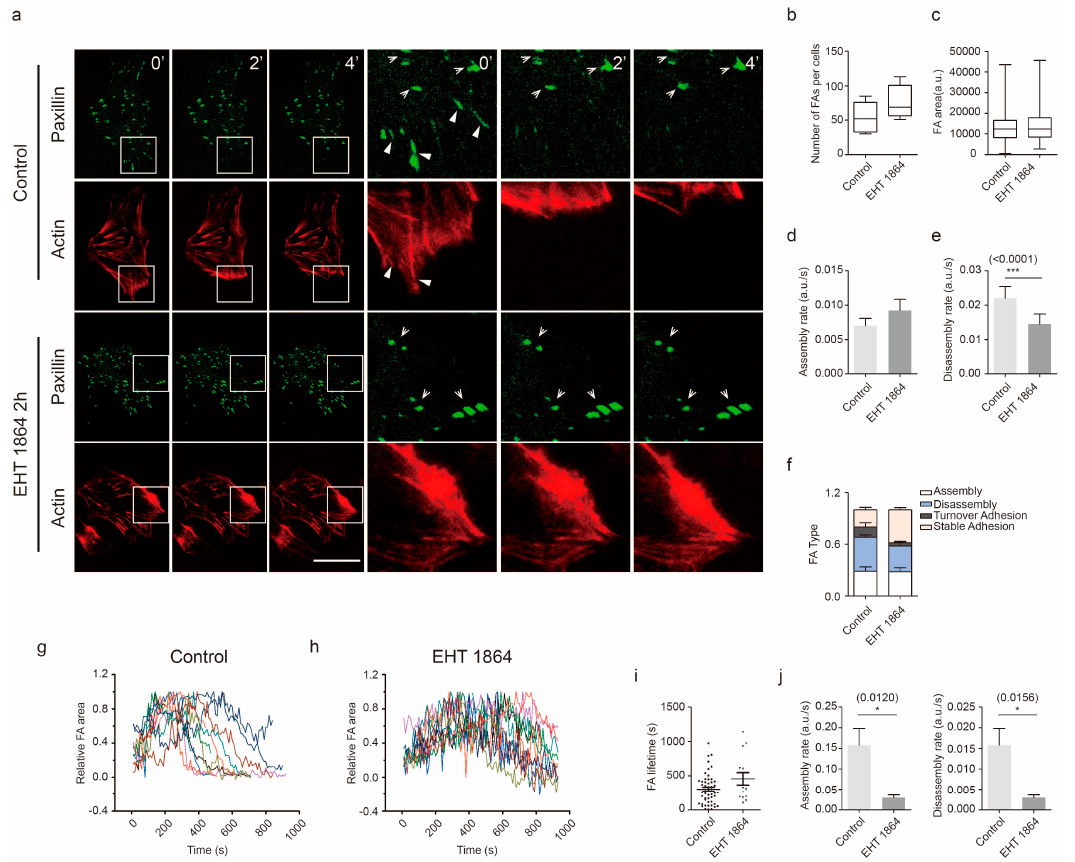
Figure 5. Rac1 signaling controls cell adhesion dynamics. ( a ) U87 transfected with Paxillin (green) and mCherry ‐ Lifeact ‐ 7 (red) were imaged by time ‐ lapse microscopy at 10 s intervals for 15 min. Time ‐ lapse images of U87 cells after 1 h of incubation with DMSO or EHT 1864, respectively. Closed arrow indicates disassembly type, and open arrow indicates cell stable adhesion. Histograms of the total cell adhesion number ( b ), adhesion area ( c ), adhesion assembly rate ( d ), and disassembly rate ( e ) and adhesion type proportion ratio in the normal and EHT 1864 ‐ treated groups ( f ). ( g–h ) Typical curves of dynamic turnover adhesions in both the control group ( g ) and EHT 1864 group ( h ). ( i ) Lifetime of turnover adhesions in the normal and EHT 1864 ‐ treated groups. ( j ) Histograms of the assembly rate and disassembly rate of turnover adhesions in the normal and EHT 1864 ‐ treated groups. Recordings are shown in Videos S8 and S9. Scale bar: 20 μ m. Tracking cell adhesion numbers: 395 in the control group and 407 in EHT 1864 ‐ treated group. ***: p < 0.001, *: p < 0.05.